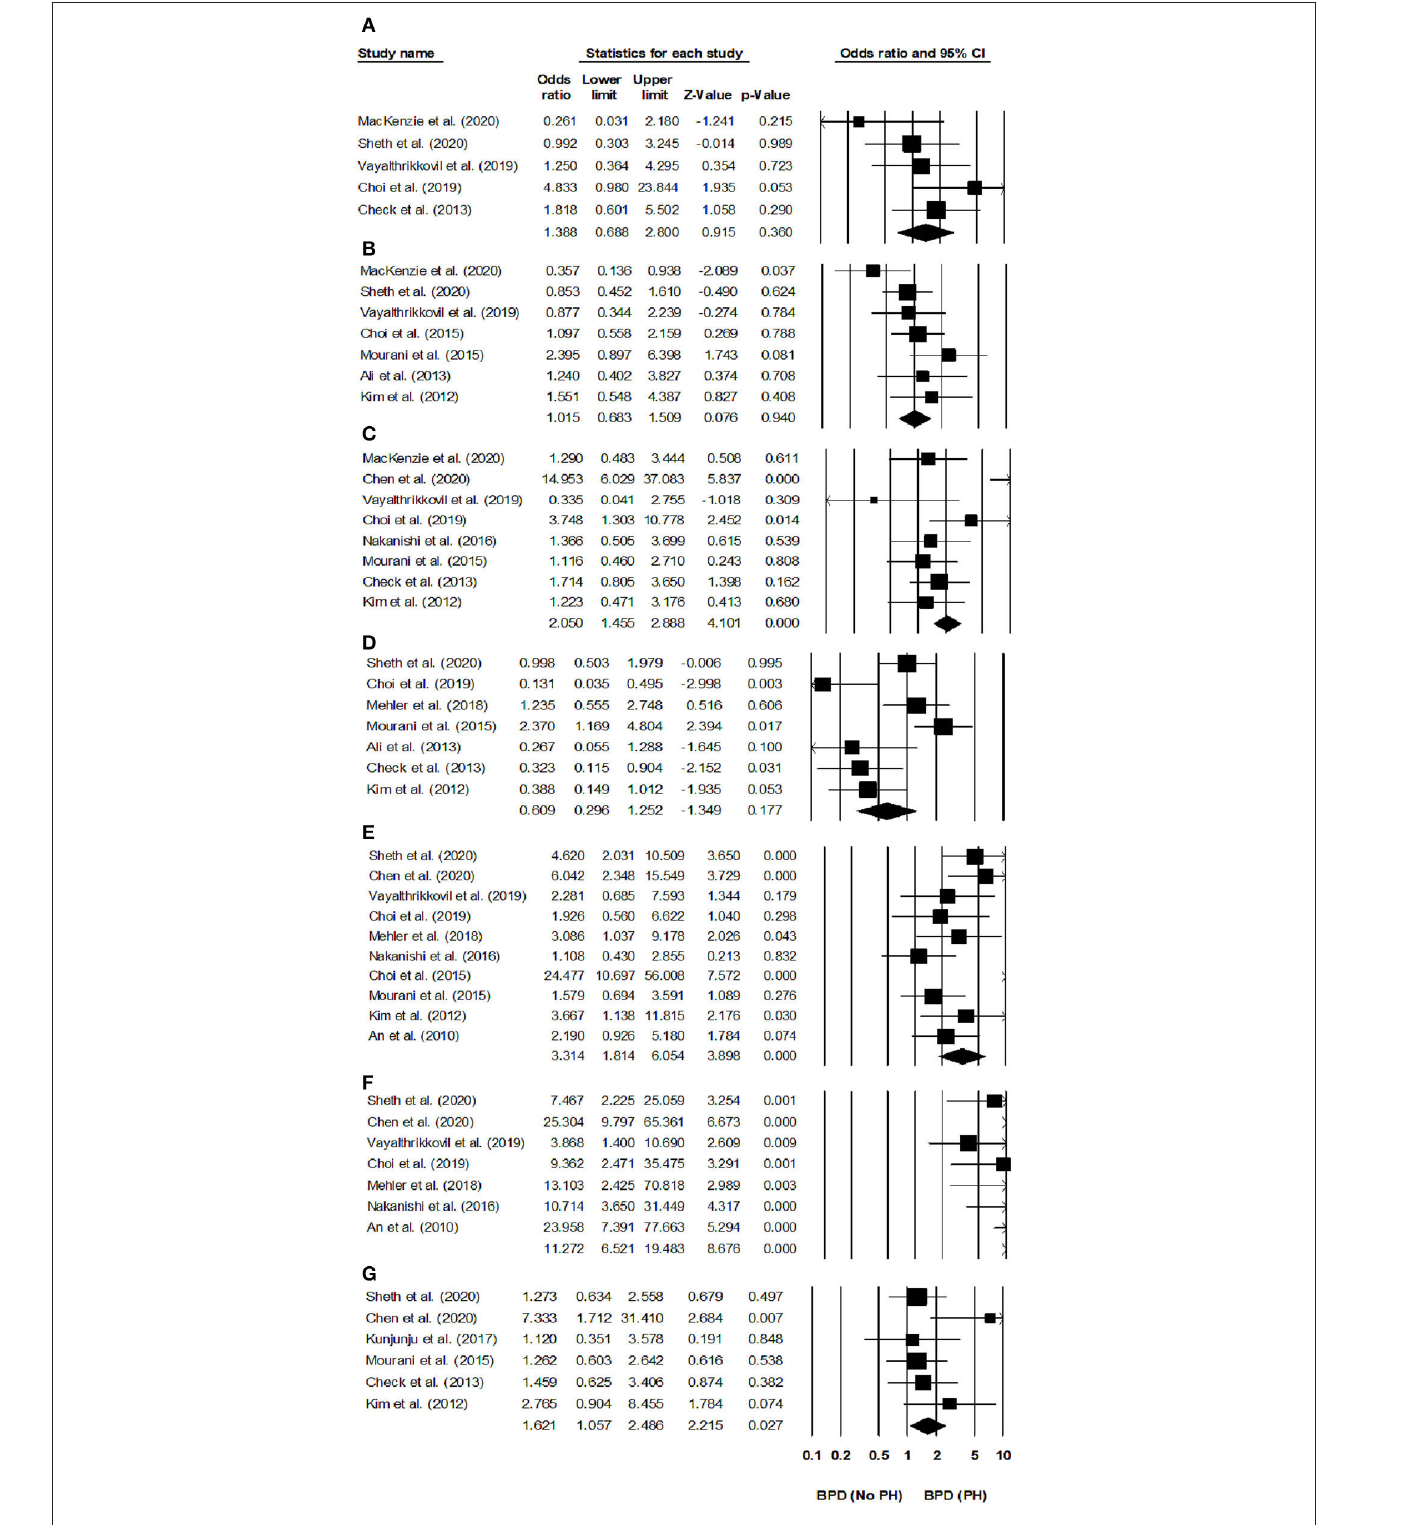
FIGURE 4 | Forest plots of risk factors for developing pulmonary hypertension in infants with BPD. Forest plot for (A) oligohydramnios, (B) cesarean operation, (C) sepsis, (D) multiple births, (E) small for gestational age, (F) BPD severity, and (G) pre-eclampsia. The odds ratio is presented as black boxes, whereas 95% confidence intervals are presented as whiskers. A negative odds ratio represents a reduced risk for developing pulmonary hypertension in infants with BPD, a positive odds ratio represents an increased risk for developing pulmonary hypertension in infants with BPD.